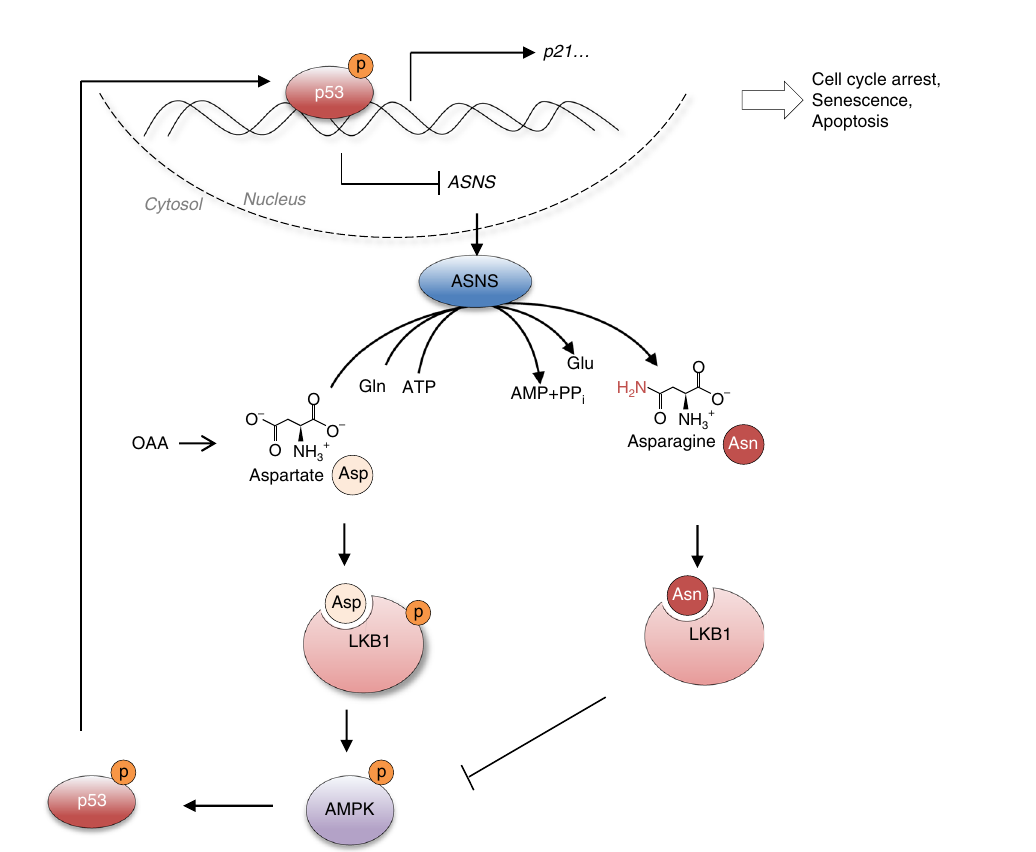
Fig. 8 A model of the reciprocal regulation of p53 and ASNS in modulating metabolism and cell states that illustrates LKB1 as a natural sensor for Asp-Asn homeostasis. Brie fl y, p53 modulates asparagine metabolism and aspartate-asparagine homeostasis through transcriptionally repressing ASNS expression. Moreover, accumulation of asparagine inhibits LKB1 activity, and whereas, aspartate suppresses its activity through direct interaction. Asn asparagine, Asp